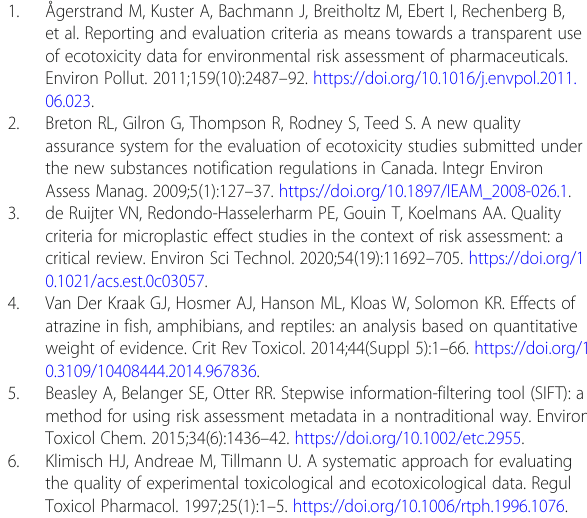
Additional file 1: Table S1. QA/QC scoring guidance against in vivo study criteria. Table S2. QA/QC scoring guidance against in vitro study